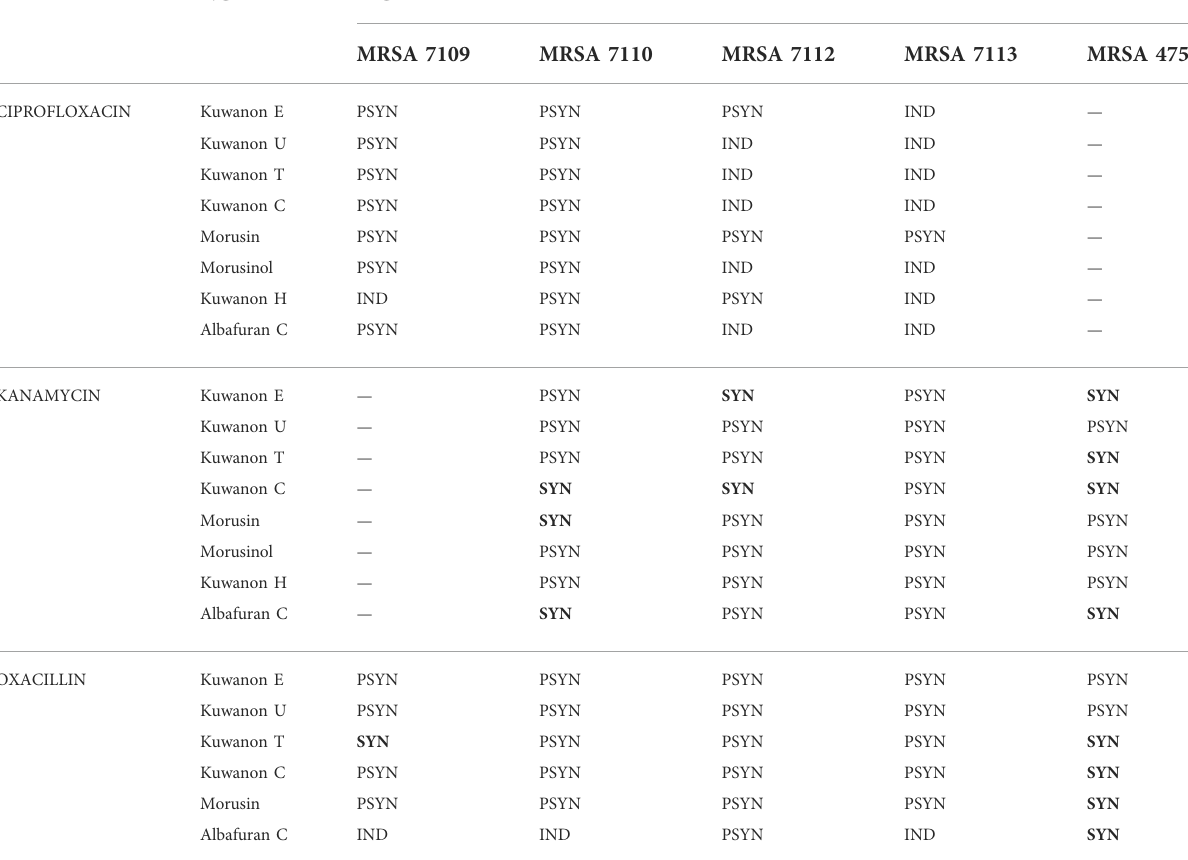
TABLE 3 The results for all interactions of natural compounds with antibiotics against MRSA strains. ATB